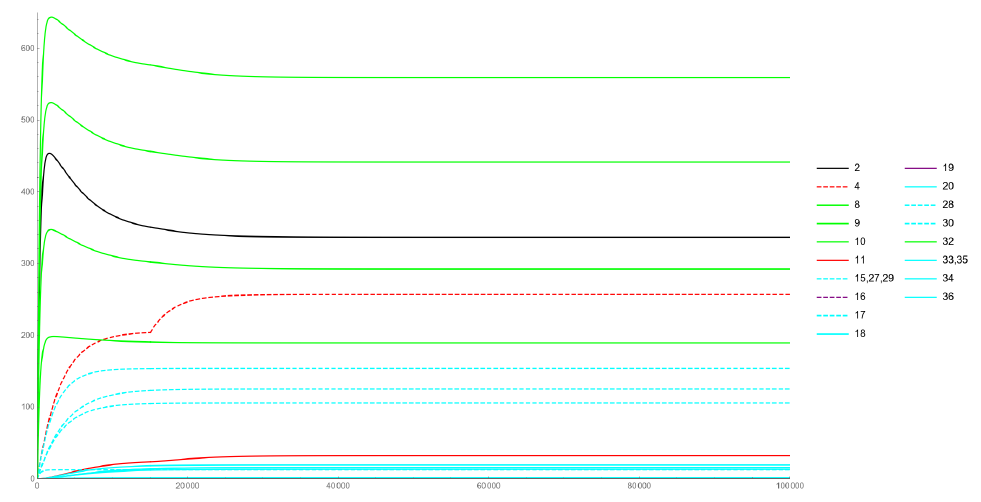
Figure 5. Duplication case.